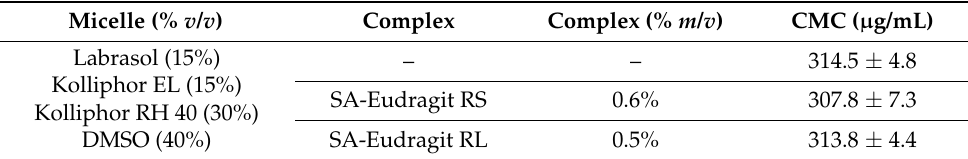
Table 2. Critical micelle concentration (CMC) values of the developed micelles.